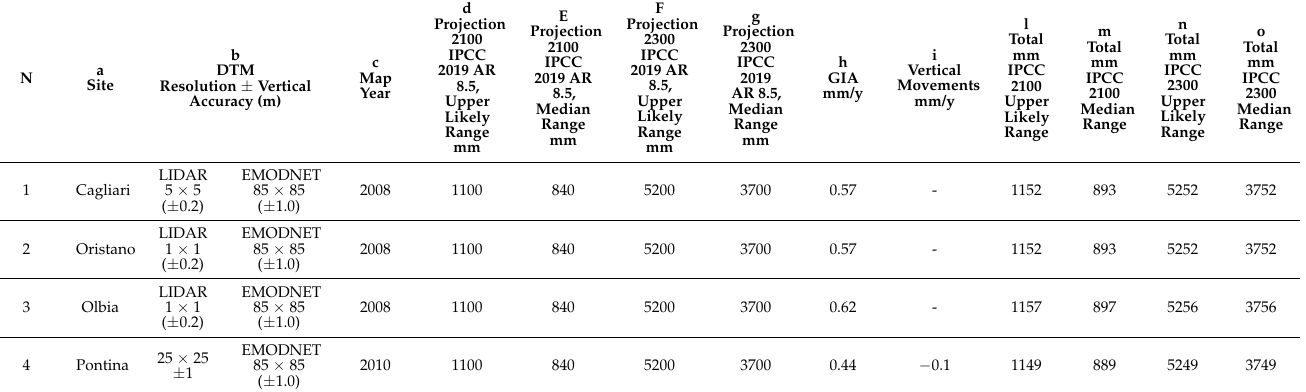
Table 1. a: site; b: (digital terrain model, DTM) resolution and accuracy; c: epoch of DTM; d–g: IPCC projection AR5-RCP8; h: glacial isostatic adjustment (GIA) rate [2]; i: vertical tectonic rate mm/year; l–o: relative sea level rise for 2100, 2300, IPCC AR5-RCP 8.5